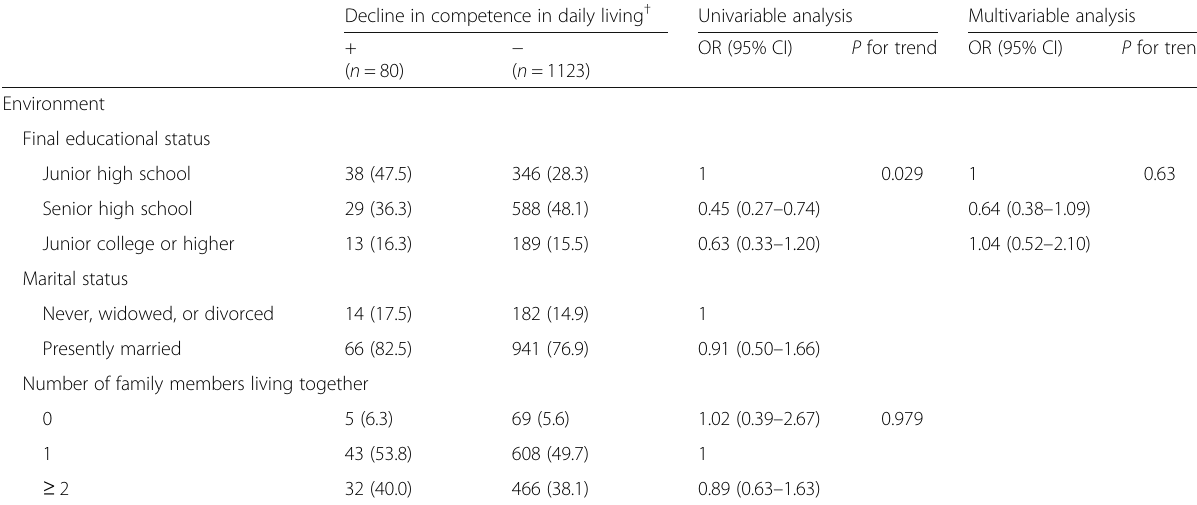
Table 3 Association of lifestyle/psychosocial factors at age 64 years with reduced competence in daily living at age 70 years (females)